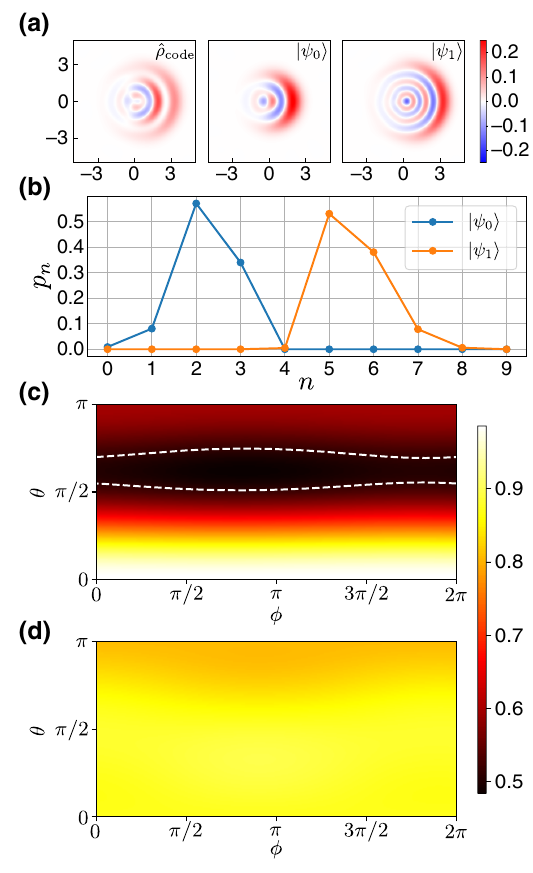
FIG. 5. (a),(b) Wigner functions and photon-number distribu- tions for the discovered encoding in Fig. 2(c)ii. (c) Single-state fidelity F θφ at t = 10 μ s for the whole Bloch sphere. The white dashed line indicates the break-even fidelity. (d) F θφ on the Bloch √ sphere for the 3 code. For all Wigner function plots throughout √ (cid:4) (cid:10) / ˆ a + ˆ a † 2 and the this paper, the horizontal axis label is x = √ (cid:4) (cid:10) / ˆ a † − ˆ a vertical axis label is p = i